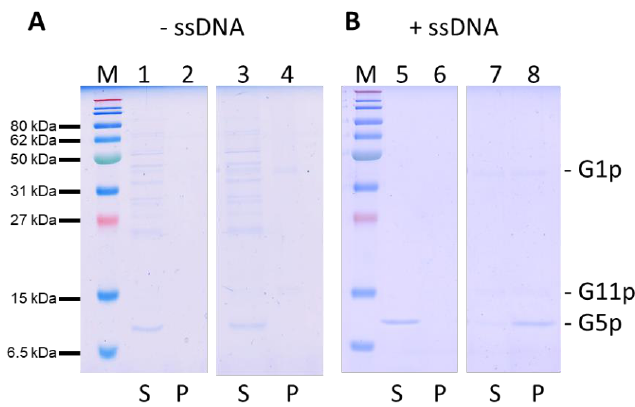
Figure 7. Binding of G5p-ssDNA to proteoliposomes containing G1p/G11pHis. ( A ) Purified G5p was added to liposomes (lanes 1, 2) or to proteoliposomes containing G1p/G11p (lanes 3, 4). ( B ) G5p-ssDNA complexes were added to liposomes (lanes 5, 6) or proteoliposomes (lanes 7, 8). After the vesicles were spun down, the supernatant (S, odd lanes) and pellet (P, even lanes) were analysed for their protein content with PAGE and Coomassie staining.